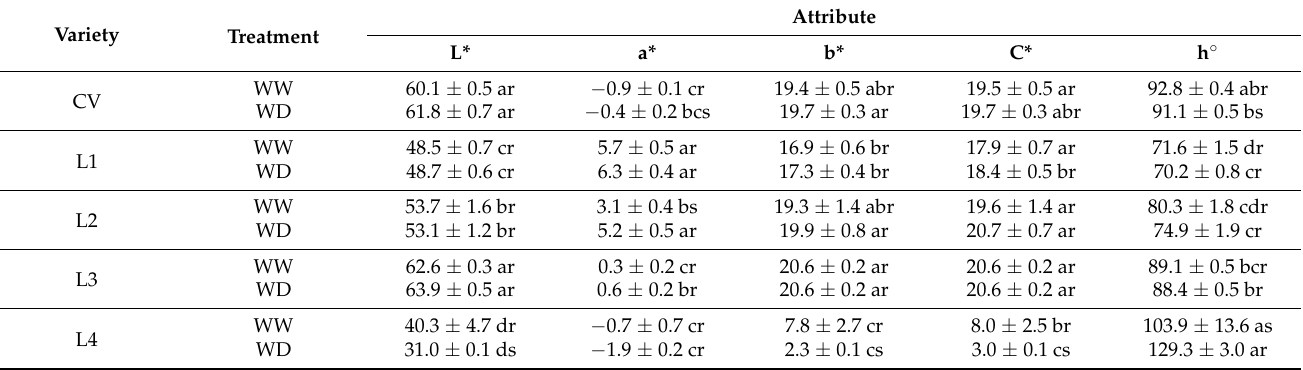
Table 4. Colorimetric analysis of Portuguese cowpea grains by the CIE L* C* h° and CIE L* a* b* sys- tem.